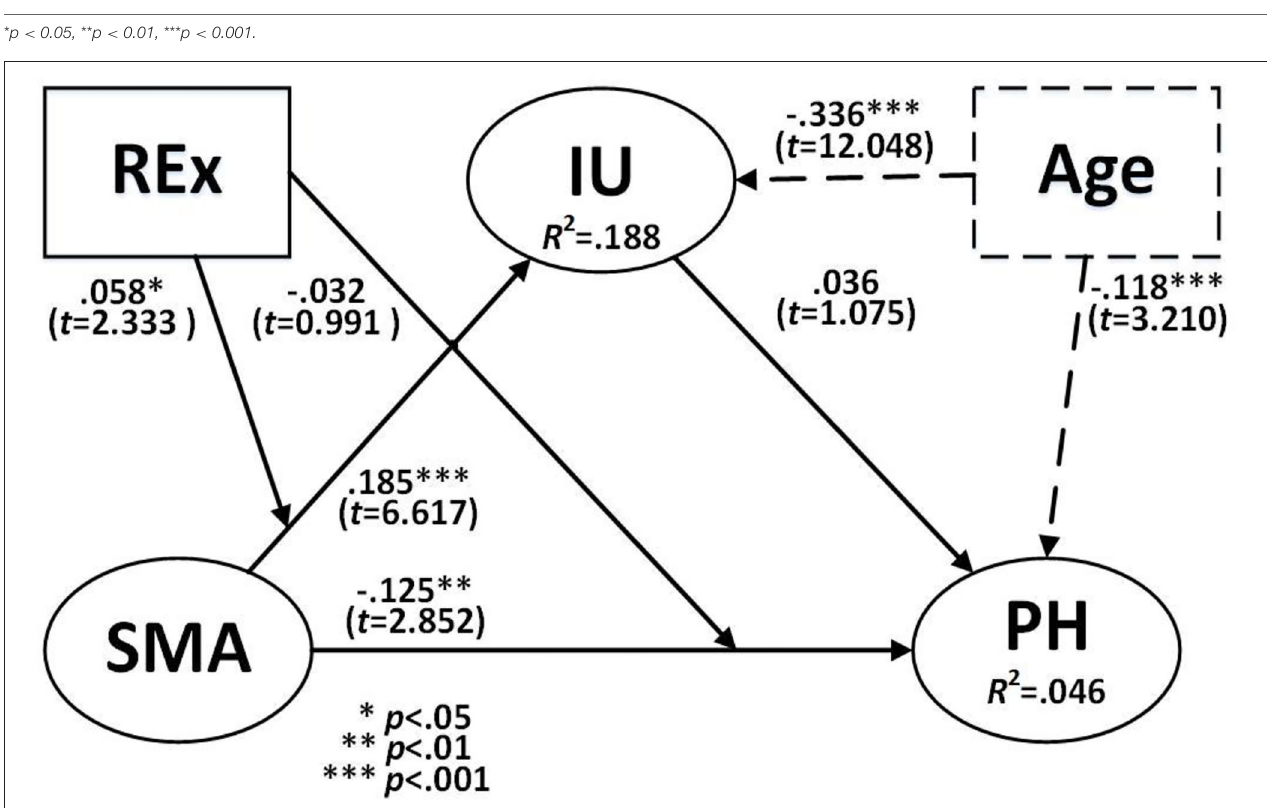
FIGURE 2 | Validation of the research model. Age is a controlled